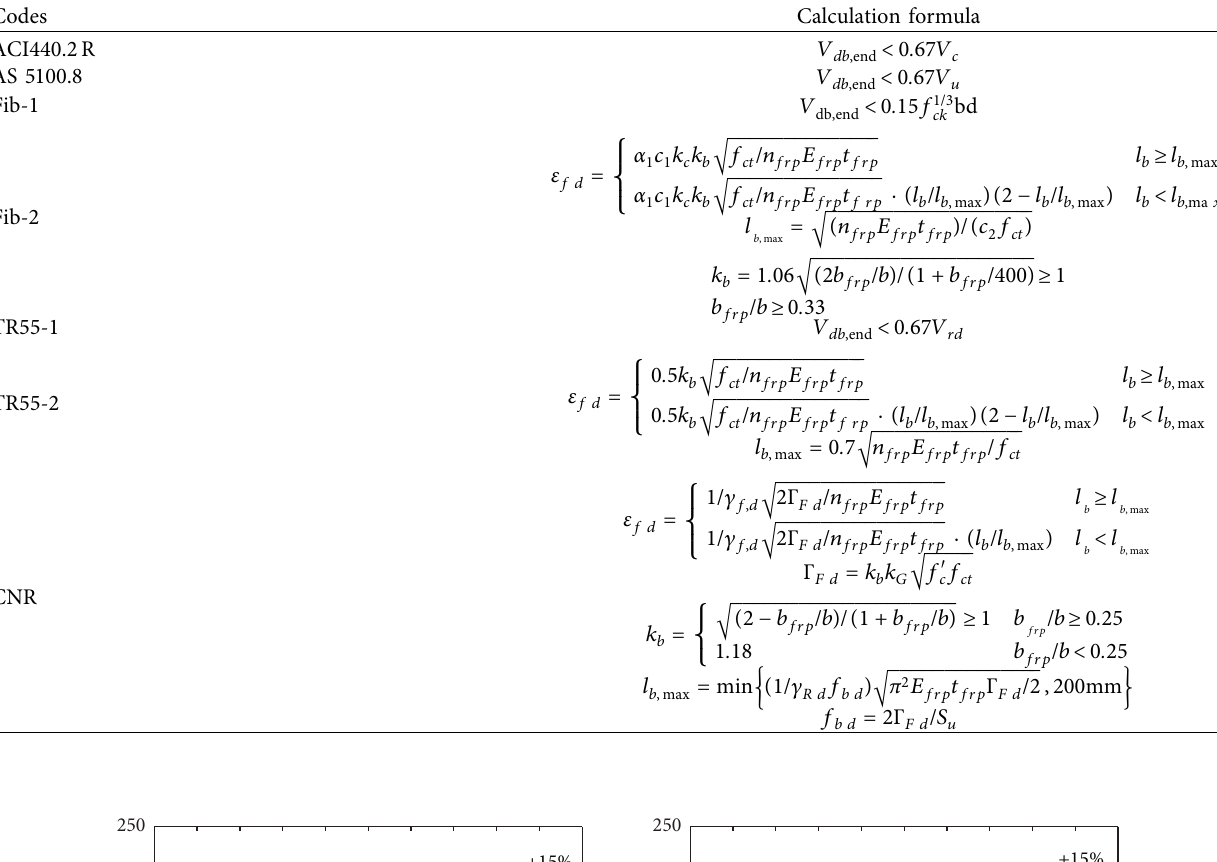
Table 1: Codes and their expressions.